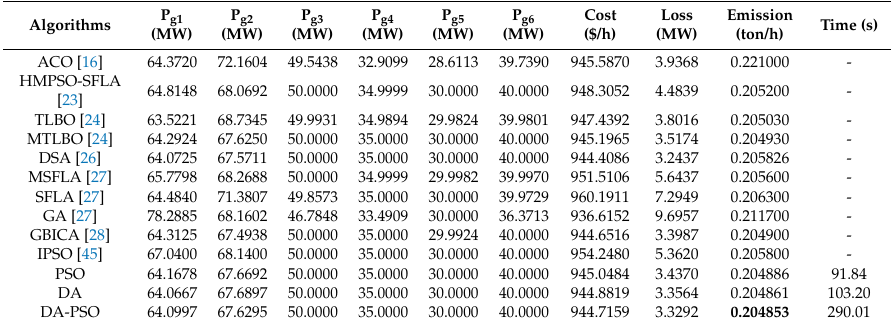
Table 3. Comparison of the results from DA-PSO and other algorithms when considering only emissions as part of the objective function for IEEE 30-bus system.